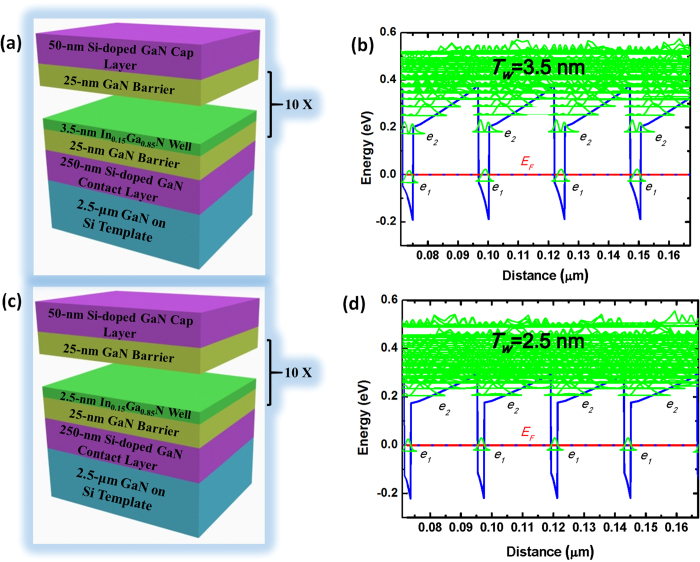
(a) Schematic image of structure and (b) conduction band profile of GaN/In0.15Ga0.85N (25 nm/3.5 nm) MQWs. (c) Schematic image of structure and (d) conduction band profile of GaN/In0.15Ga0.85N (25 nm/2.5 nm) MQWs.